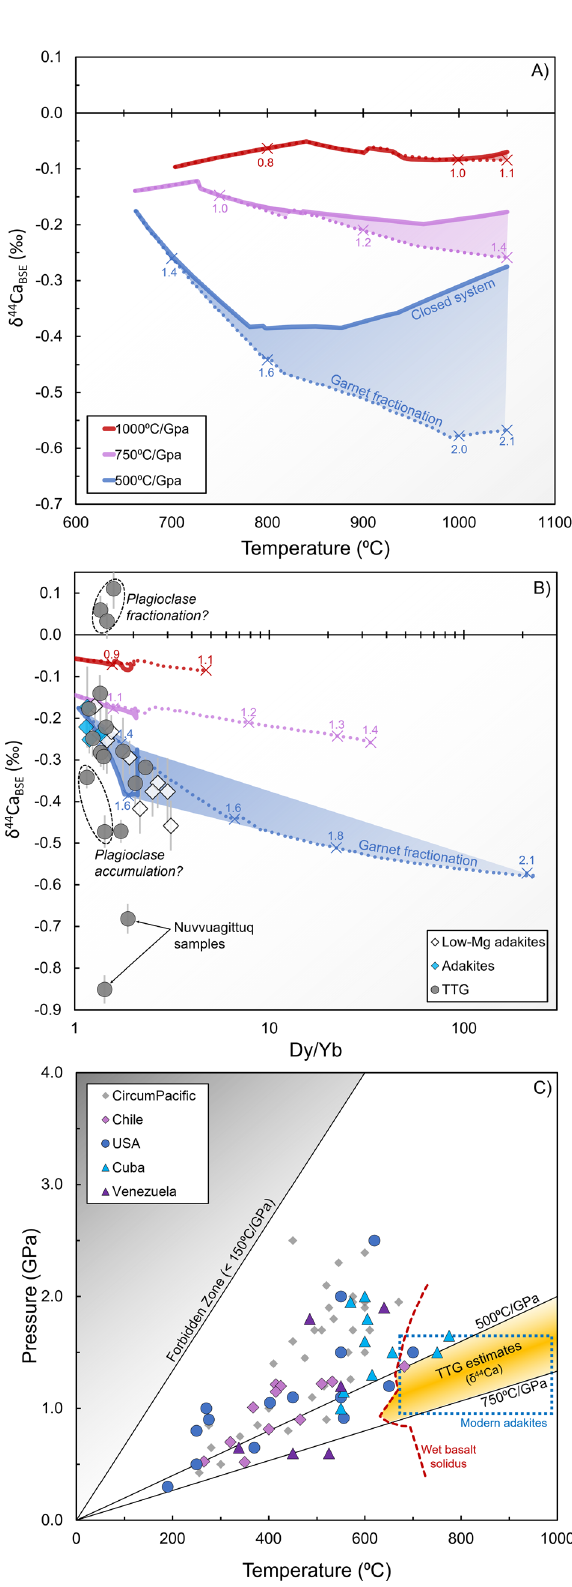
below our model predictions for 500 °C/GPa, two have positive